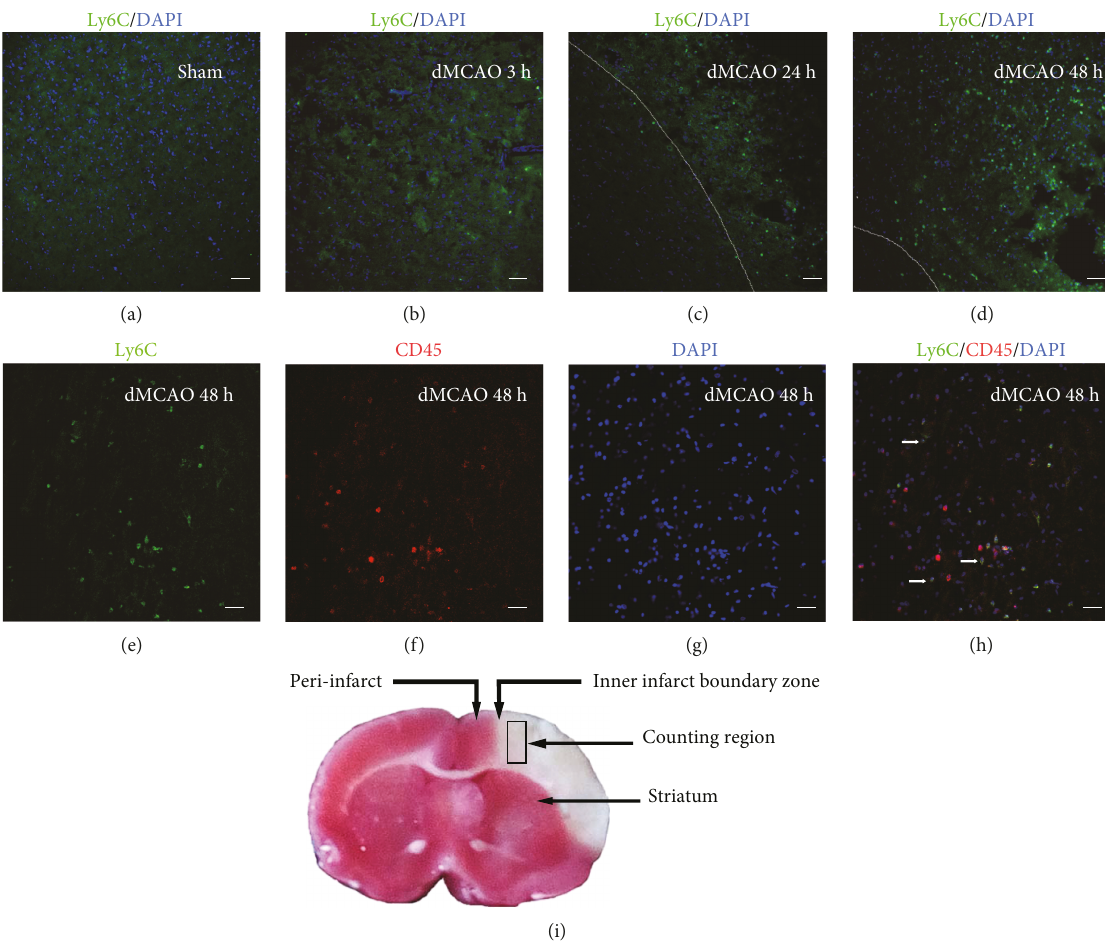
Figure 1: Ly6C + cells in the ischemic core cortex. The number of Ly6C + cells gradually increases at the IBZ of infarct dMCAO in rats. (a) Ly6C staining of the sham group. (b) Ly6C staining of the infarct area 3h after the onset of ischemia. (c) 24 h. (d) 48 h. (e) Ly6C staining in the infarct area at 48h. (f) CD45 staining in the same view fi eld as (e). (g) DAPI nucleus staining. (h) Merged image of (e), (f), and (g), showing that Ly6C-positive cells are all CD45-positive. Arrow: double-labeled cells. (i) Cerebral infarct of the “ ischemia +vehicle ” group, as stained by triphenyltetrazolium chloride (TTC). Rectangle: the area where cell counting was performed. Dotted lines: the boundary of the infarct areas. Scale bar, 50 μ